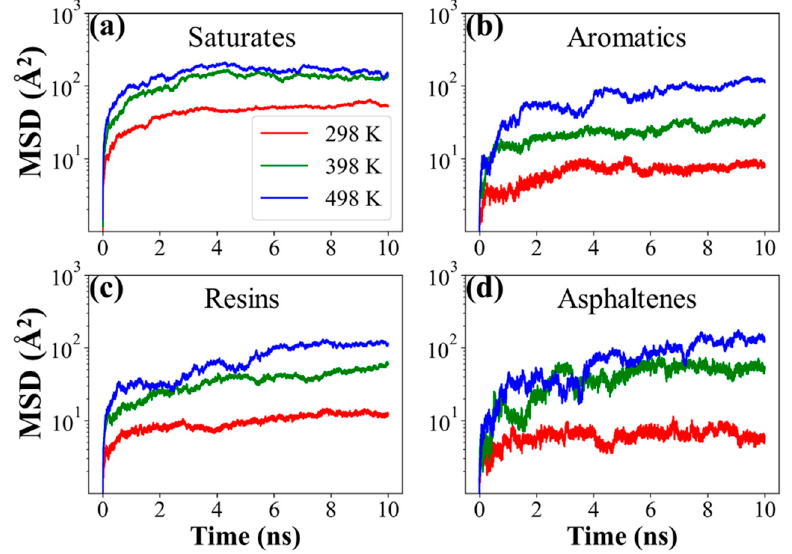
Figure 12. The MSD curves of saturates, aromatic, resin, and asphaltene molecules in nanopore at 298 K, 398 K, and 498 K, respectively.